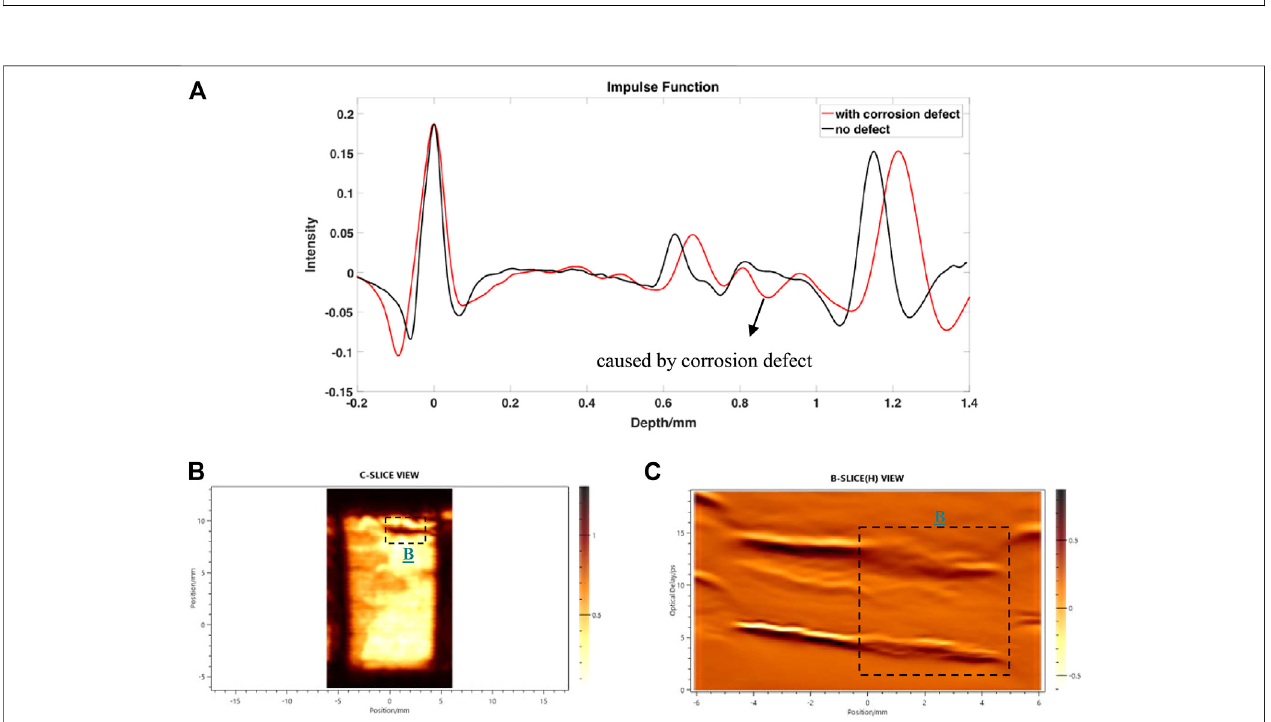
FIGURE 4 | TPI result of the “ three antifouling paint layer + one “ link-coat ” layer + two anticorrosion paint layer + metal substrate ” coating system with corrosion defect. (A) Impulse function comparison of defective coating and the perfect one, (B) C-SLICE view of detected sample, (C) B-SLICE view of detected sample.